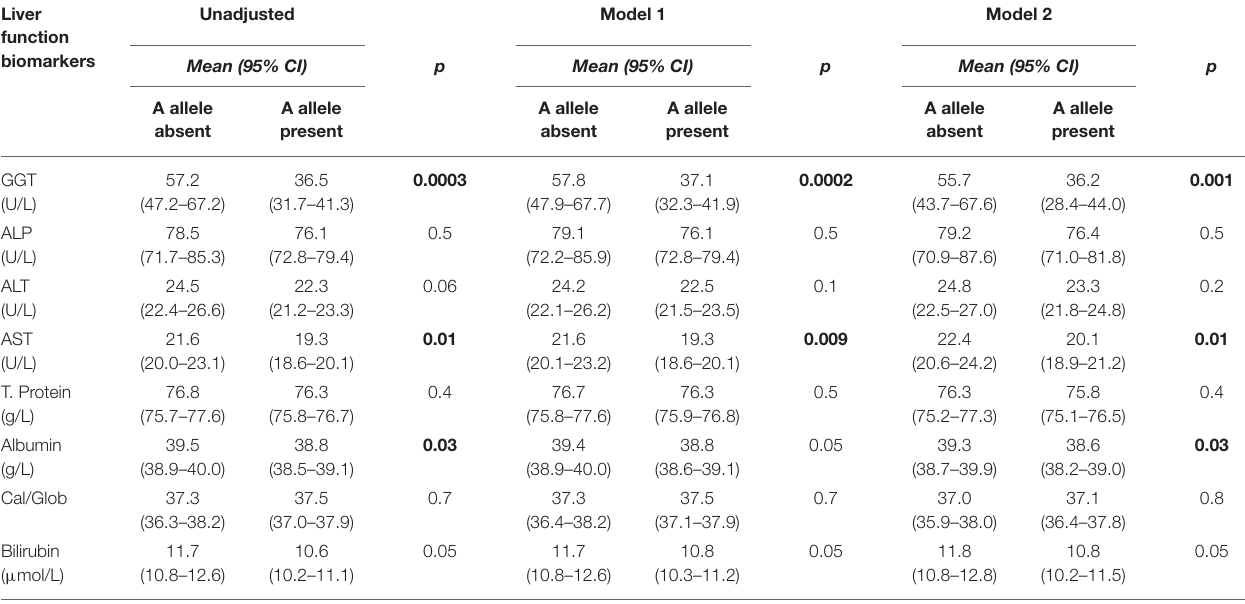
TABLE 5 | Liver function biomarkers vary by the presence of the KCNJ2 -A allele in unadjusted and adjusted models. Liver